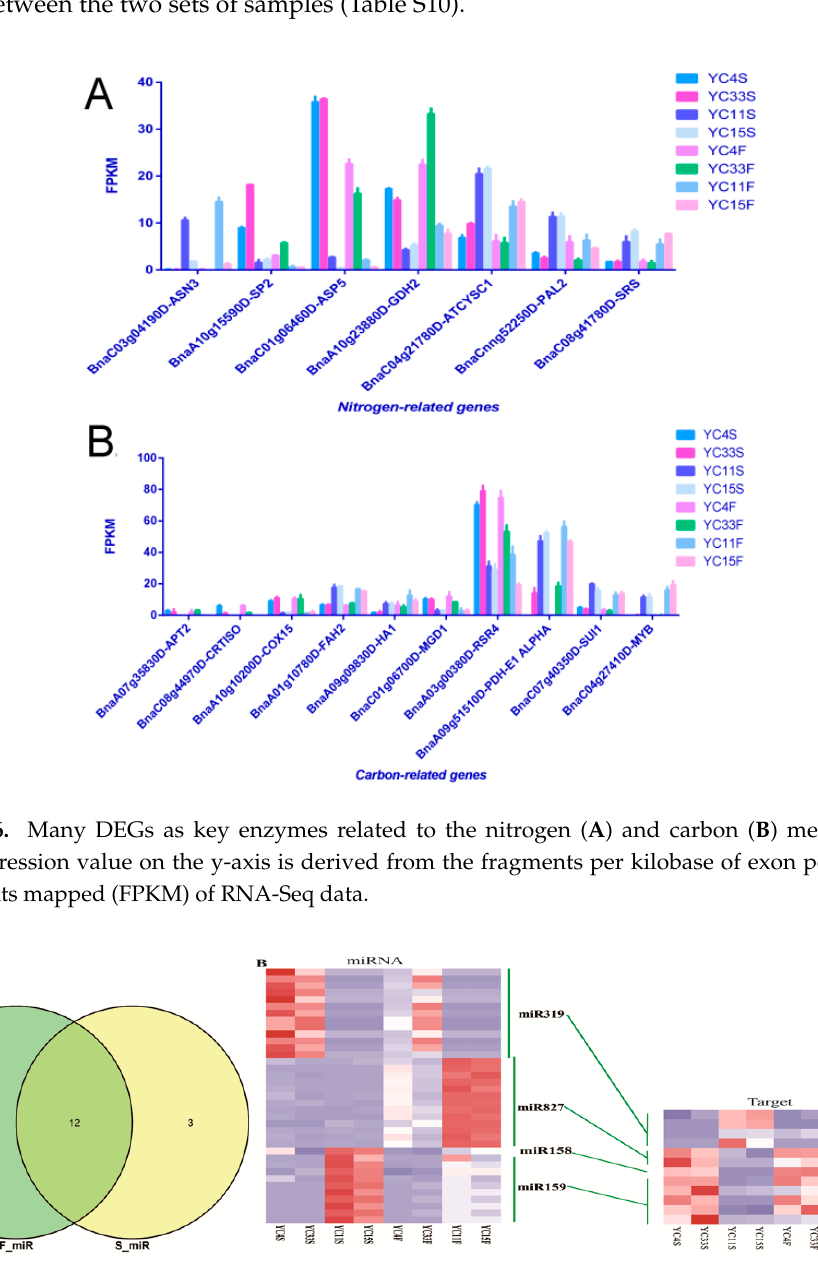
Figure 7. Identification of abundant known microRNAs (miRNAs) ( A ) and those regulating genes related to the nitrogen and carbon metabolisms ( B ).